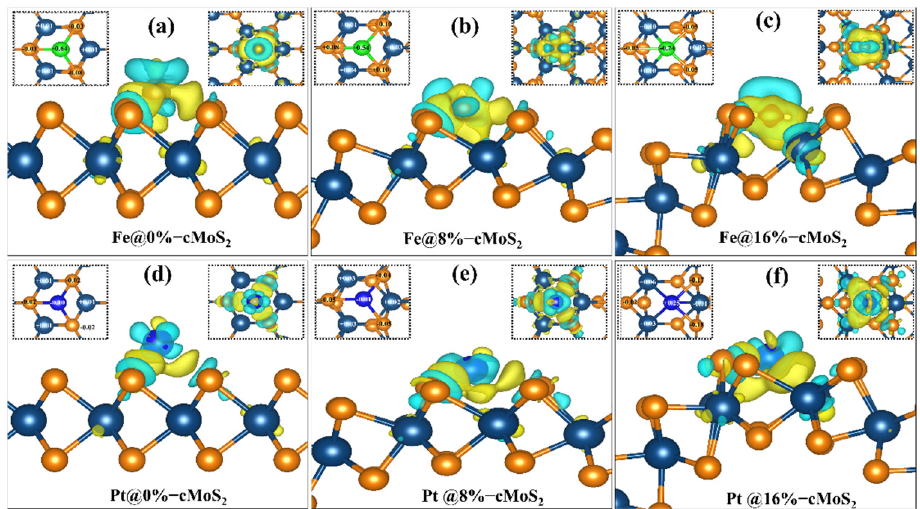
Figure 3. ( a – f ) The charge density difference between cMoS 2 and Fe@cMoS 2 (the upper)/Pt@cMoS 2 (the lower). The yellow and blue represent the charge accumulation and dissociation. The left and right insets indicate the Bader charge change around absorbents and the top view of charge density difference for each situation. The isosurface value is set to 0.004 e/Å 3 .